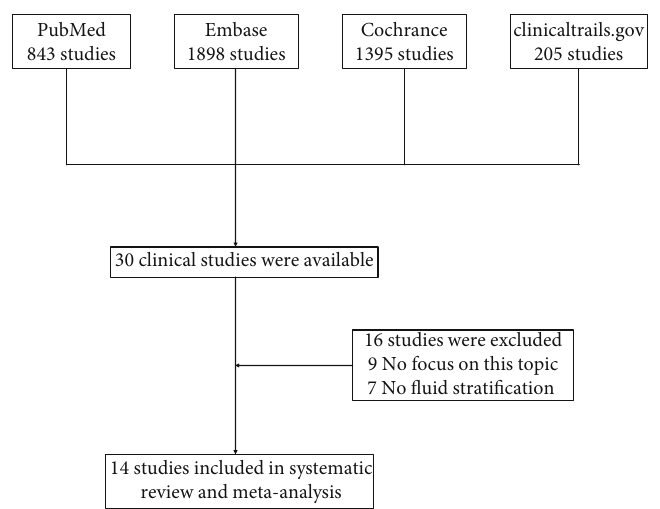
Figure 1: Flow diagram of study